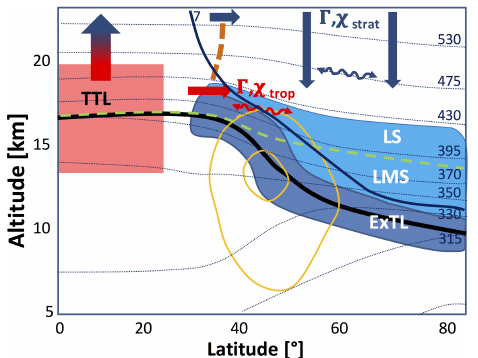
Figure 1. Cross section of the Northern Hemispheric UTLS (upper troposphere – lower stratosphere) region, adapted from Riese et al. (2014) and Müller et al. (2016). The thermal tropopause is denoted by the thick black solid line. The measurement region is depicted as a blue box subdivided into the extratropical tropopause layer (ExTL), the lowermost stratosphere (LMS) and the lower strato- sphere (LS). LMS and LS are separated by the 380K isentrope (green dashed line). Transport pathways of air masses are denoted by coloured, thick arrows from the tropical tropopause layer (TTL) (red) and the polar Arctic upper stratosphere (blue) with respective mean age (cid:48) and trace-gas volume mixing ratio χ . Quasi-horizontal mixing is represented by wavy double side arrows, indicating no net mass transport of air masses. Dotted lines are isentropes in K. The solid dark blue line indicates the 7PVU contour, which is used to separate the regime of the ExTL from the LMS and LS (for details see text). Thin orange contour lines depict the zonal view of the jet